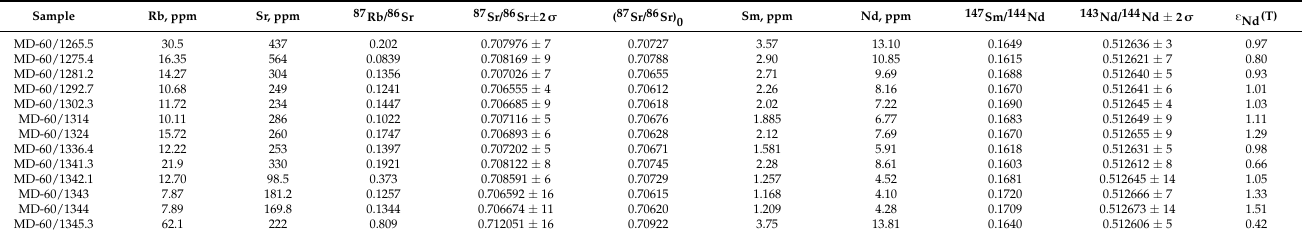
Table 1. Results of Rb-Sr and Sm-Nd isotopic systems analysis of the gabbro-dolerites